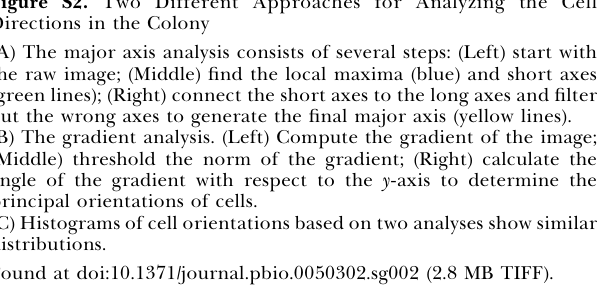
Figure S1. A Representative Map of the Plasmid pJWP01S Used for Visualization of lux Operon Expression pPROBE- gfp (tagless) with lux R- lux box-P luxI Inserted into the Eco RI- Kpn I Sites of Multiple Cloning Site. Found at doi:10.1371/journal.pbio.0050302.sg001 (659 KB TIFF). Figure S2. Two Different Approaches for Analyzing the Cell Directions in the Colony (A) The major axis analysis consists of several steps: (Left) start with the raw image; (Middle) find the local maxima (blue) and short axes (green lines); (Right) connect the short axes to the long axes and filter out the wrong axes to generate the final major axis (yellow lines). (B) The gradient analysis. (Left) Compute the gradient of the image; (Middle) threshold the norm of the gradient; (Right) calculate the angle of the gradient with respect to the y -axis to determine the principal orientations of cells. (C) Histograms of cell orientations based on two analyses show similar distributions. Found at doi:10.1371/journal.pbio.0050302.sg002 (2.8 MB TIFF). Figure S3. Quantification of Cell Outflow from the RIR Chamber (A) Quantification of the flow of cells from the RIR chamber toward an exit in a densely packed colony. Three consecutive time intervals were selected, all at the stage of the steady-state colony growth. For each time interval, 10 individual cells were chosen from the inner side of one of the green-shaded regions in the chamber shown in the inset (closer to the center of the chamber), and their positions on